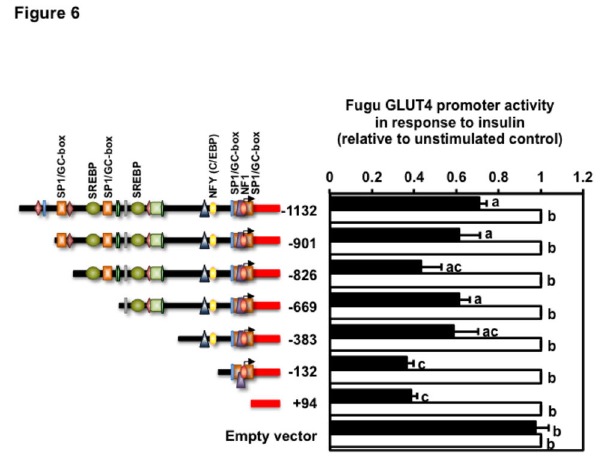
Figure 6. Activity of the Fugu GLUT4 promoter deletion constructs in response to insulin. L6 muscle